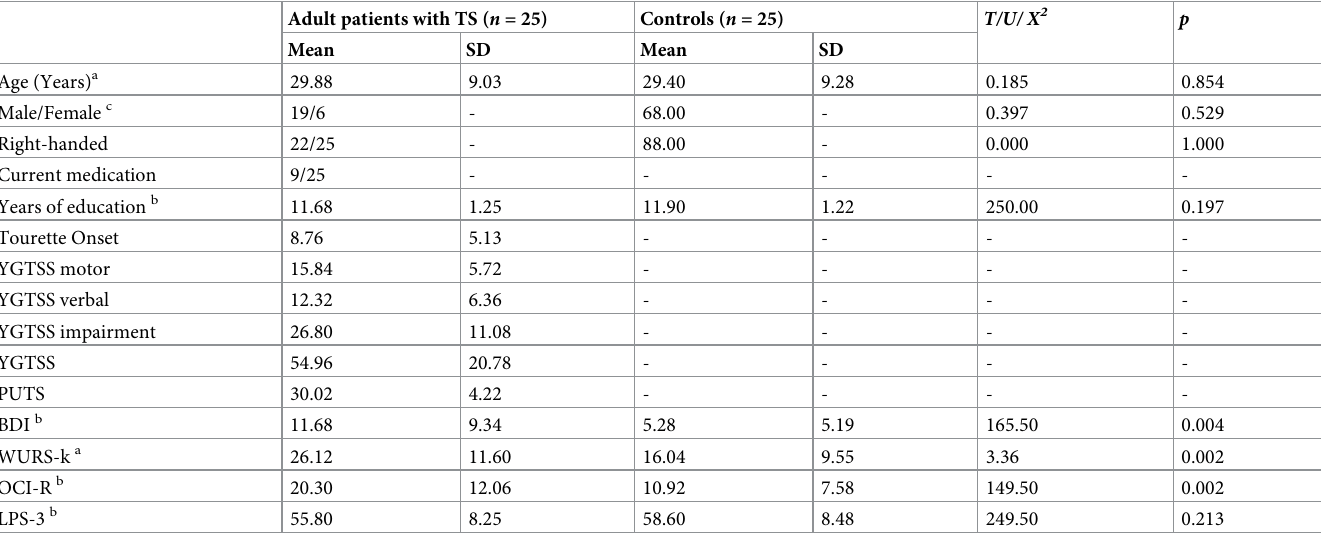
Table 3. Demographic, clinical and neuropsychological characteristics of patients with TS and healthy controls. Adult patients with TS ( n =